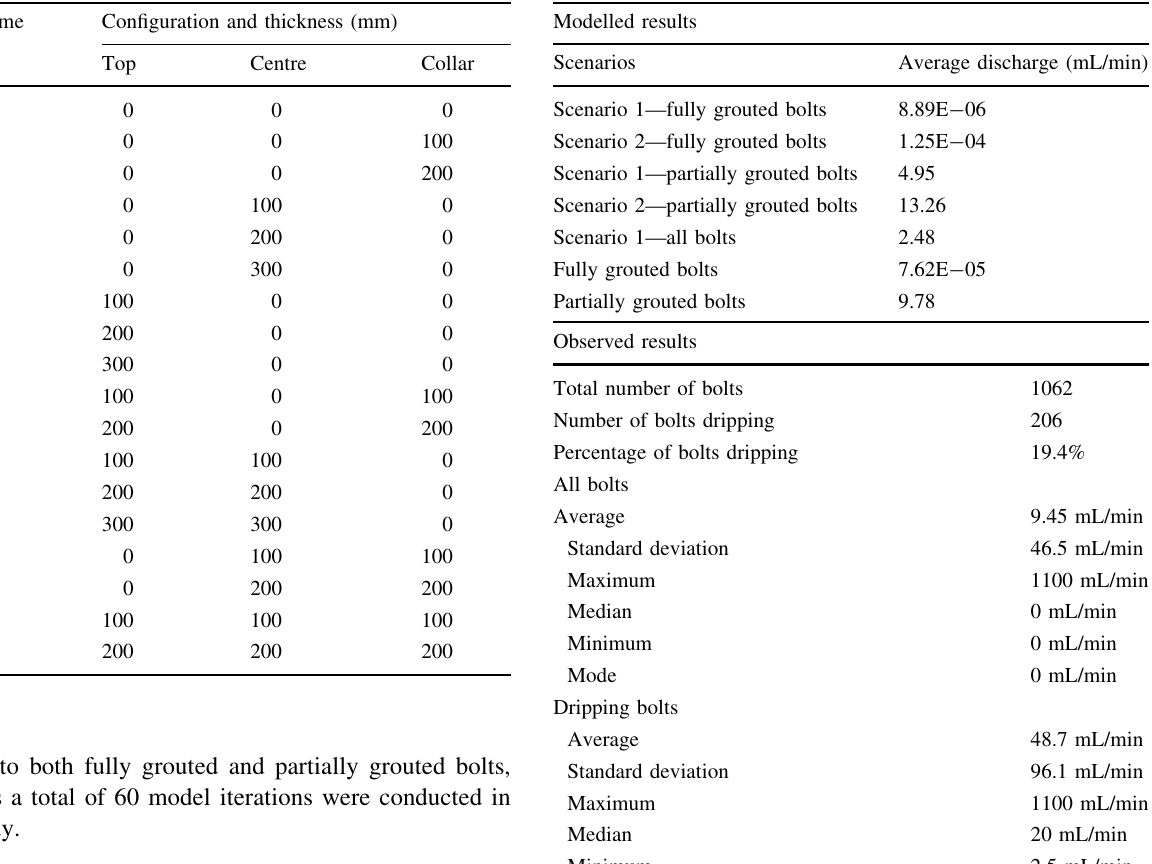
Table 2 Model iterations of Scenario 2—varying claystone band configurations